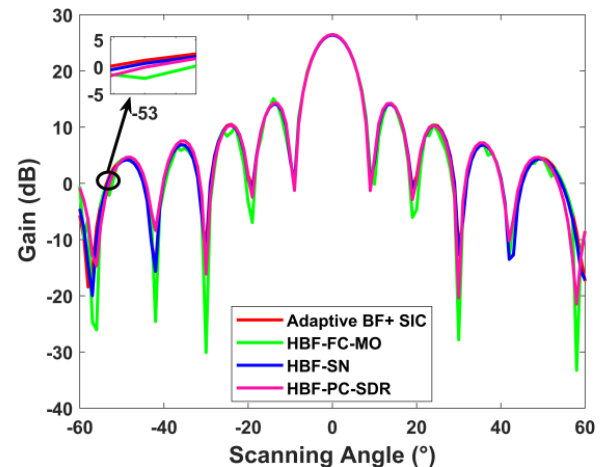
Figure 9. Pattern at 0 ◦ of three categories of simplified structure and FD-ALSTAR receiver.